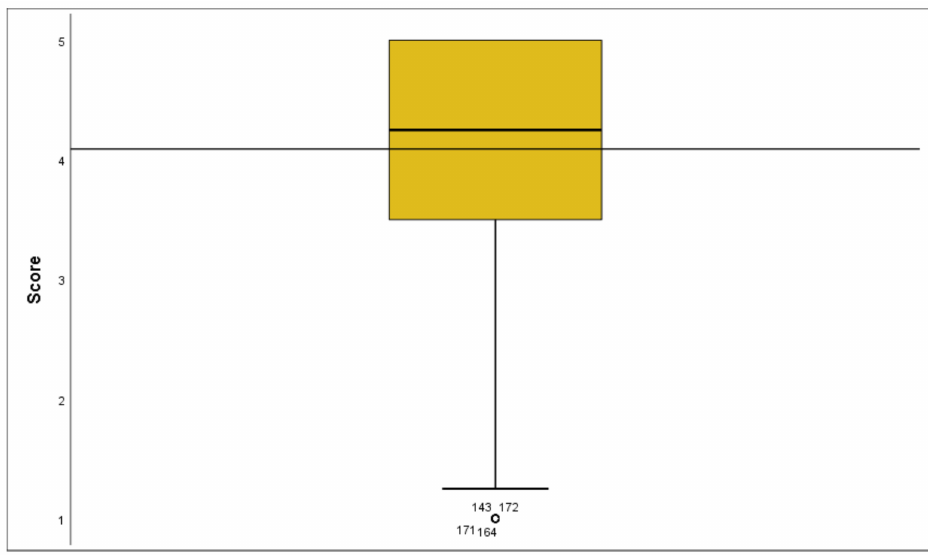
Figure 2. Frequency with which guests engage in water-saving habits on a scale of 1 (never) to 5